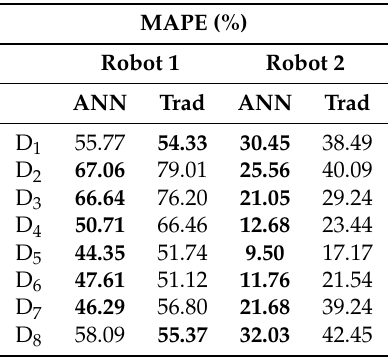
Table 1. Mean Absolute Percentage Error for both models and robots.